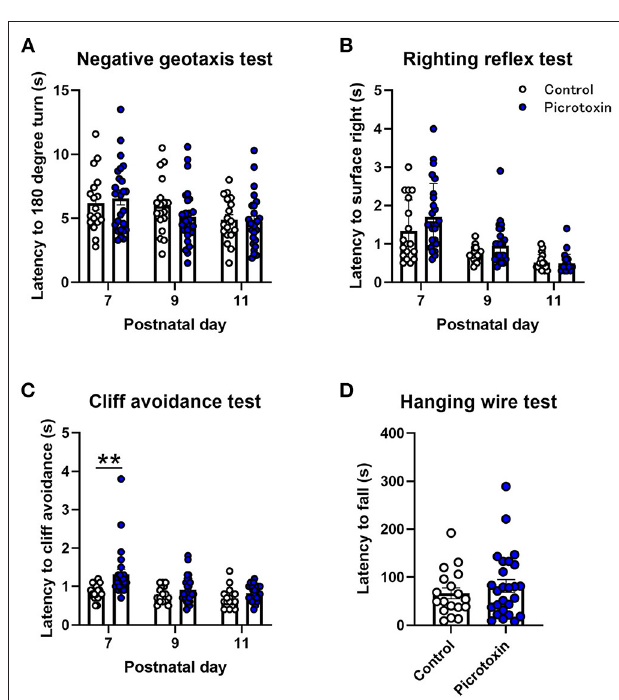
FIGURE 2 | Motor function tests. (A) No significant difference in the negative-geotaxis test was found between control and picrotoxin-exposed male mice. (B) No significant difference in the righting reflex test was found between control and picrotoxin-exposed male mice. (C) Picrotoxin-exposed male mice exhibited a significantly longer latency to cliff avoidance. (D) No significant difference in the hanging-wire test was found between control and picrotoxin-exposed mice. The data expressed as mean ± SEM. ** p < 0.01 (two-way repeated-measures ANOVA). mice, n = 26 picrotoxin-exposed mice; Figure 3A ]. In adulthood, picrotoxin-exposed male mice exhibited a decrease in active interaction time compared with control male mice [ t (42) = 2.723,